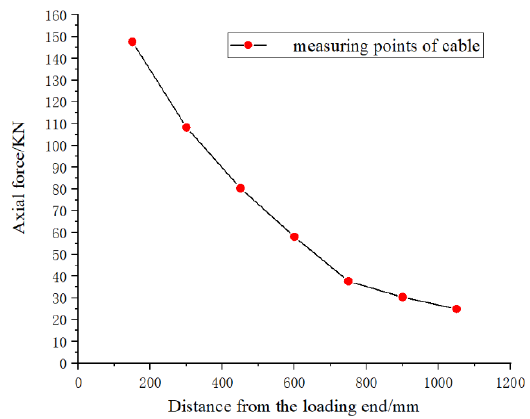
Figure 6. Axial force distribution of the cable.